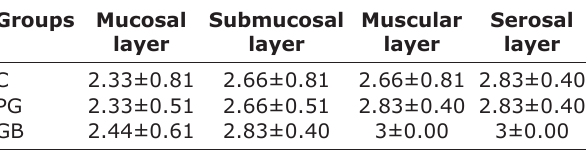
Table-1: The scoring of histologic data obtained from mucosal, submucosal, muscular and serosal layer